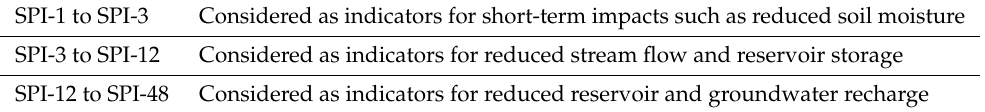
Table 4. Different SPI indicators for estimating potential impacts of a drought (extracted and adapted from the European Drought Observatory (EDO)